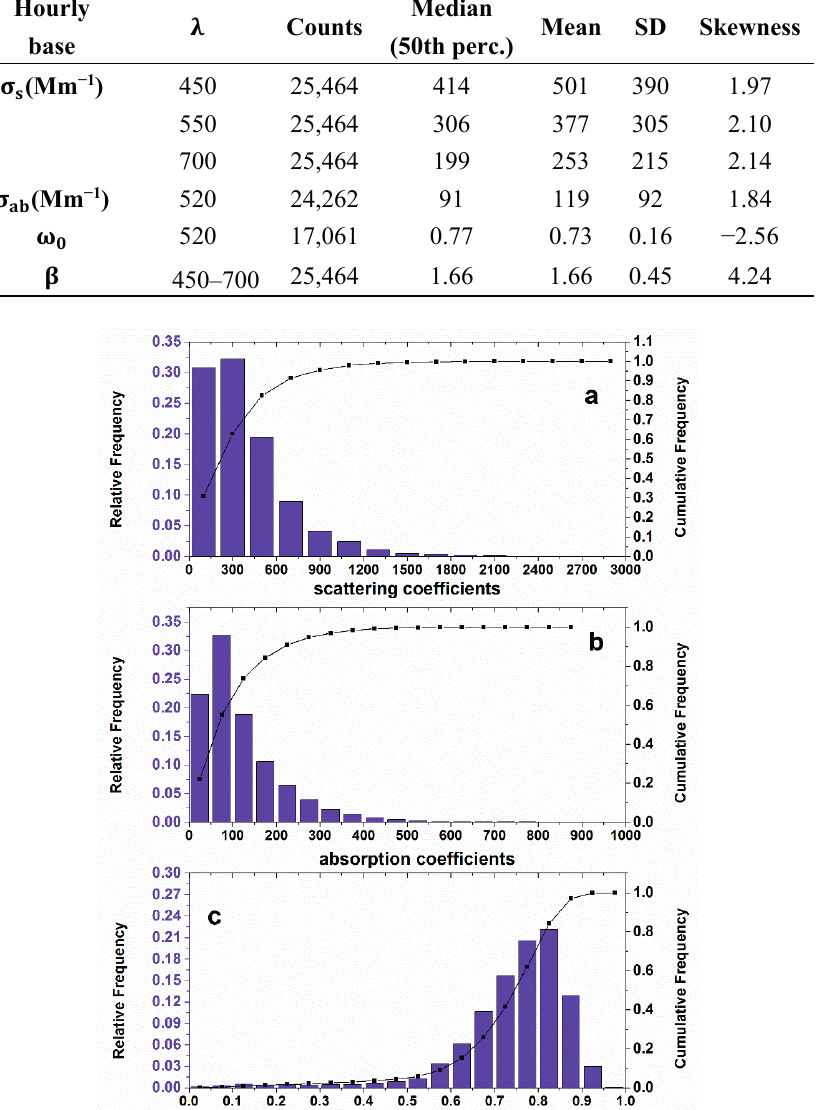
Figure 3. Relative and cumulative frequency distributions of aerosol optical properties: ( a ) aerosol scattering coefficients ( σ single scattering albedo